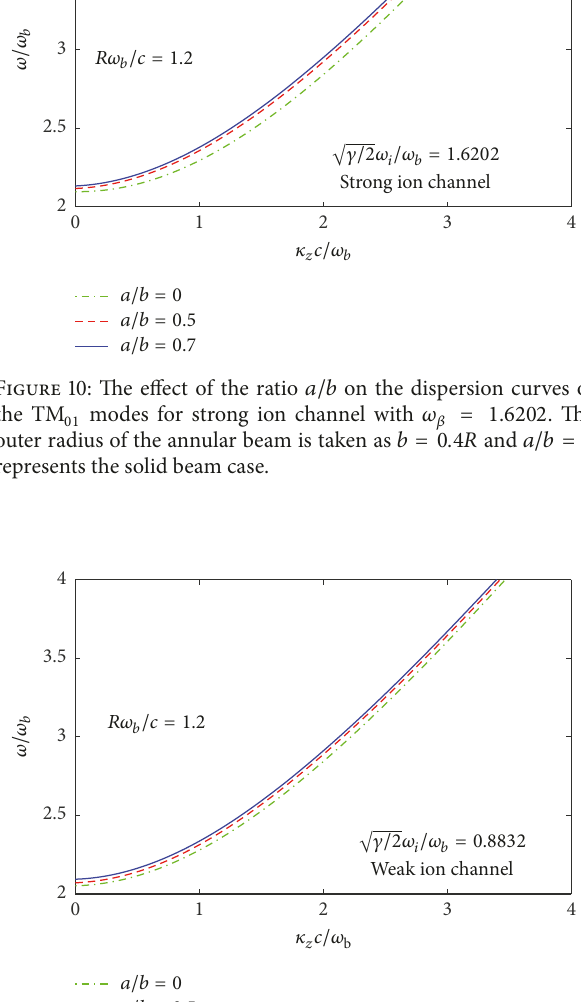
Figure 13: The effect of betatron oscillation parameter 𝜔 𝛽 on the dispersion characteristics of the TM 01 modes for strong ion channel. The inner and outer radius of the annular beam are taken as 𝑎 = 0.25𝑅 and 𝑏 = 0.5𝑅 . The Lorentz factor is 𝛾 = 6